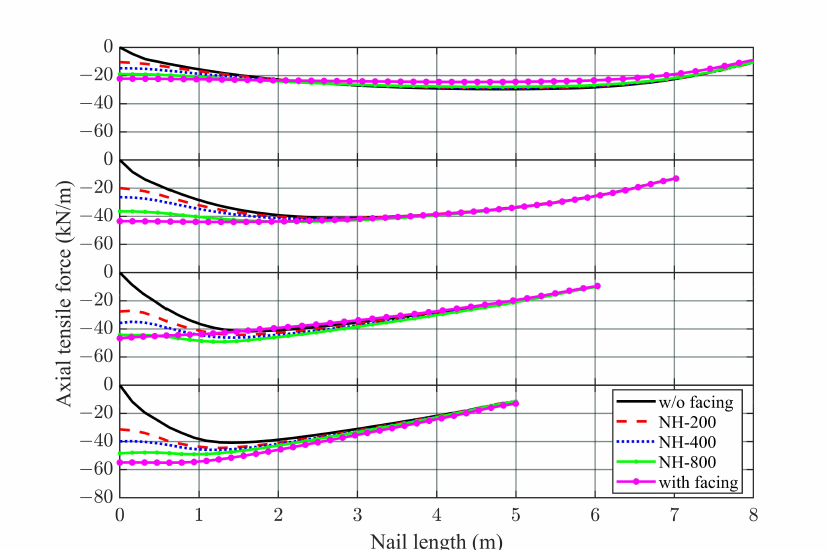
Figure 8. Distribution of nail axial force for nail heads of various sizes and facing element.